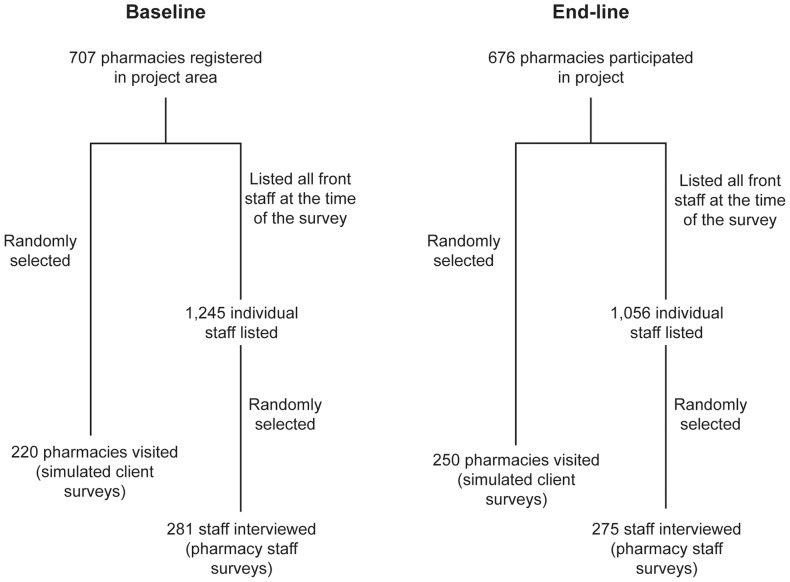
Sampling process for pharmacy staff and simulated client surveys*.